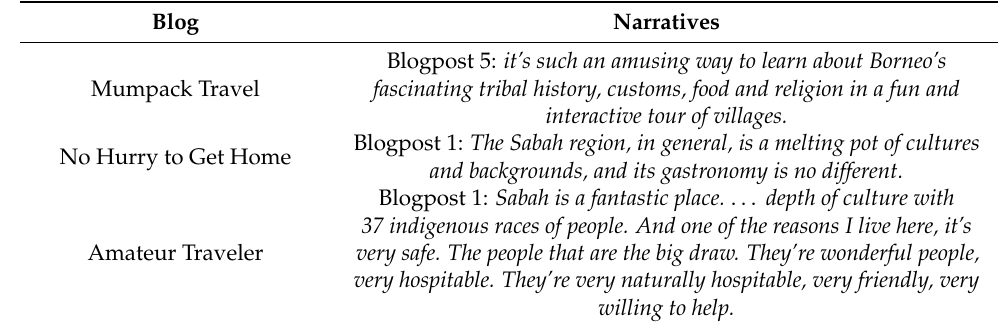
Table 6. Emotional Narratives on Theme Culture.